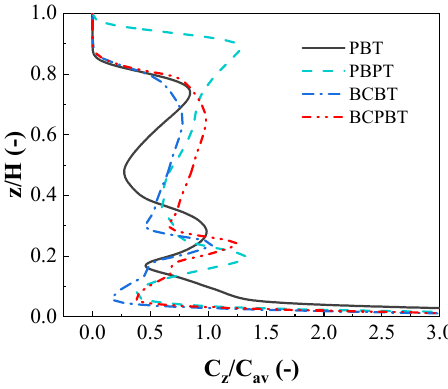
Figure 12. Effect of impeller type on local axial solid concentration profile.